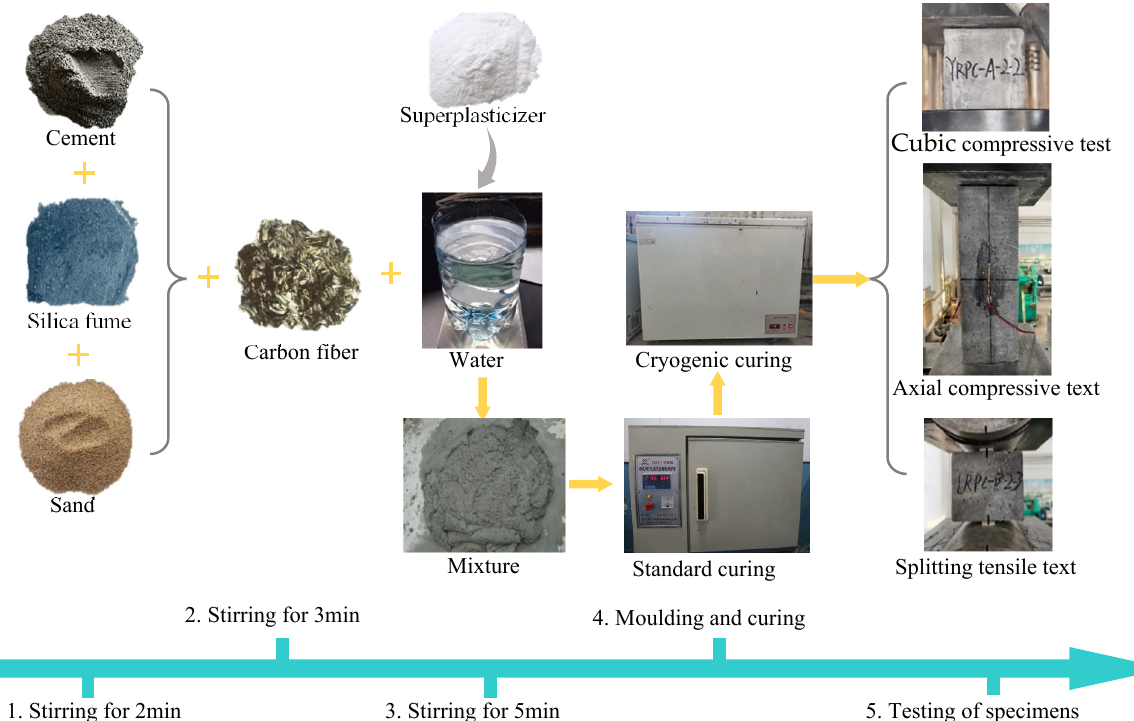
Figure 2. Preparation and test of process specimens.